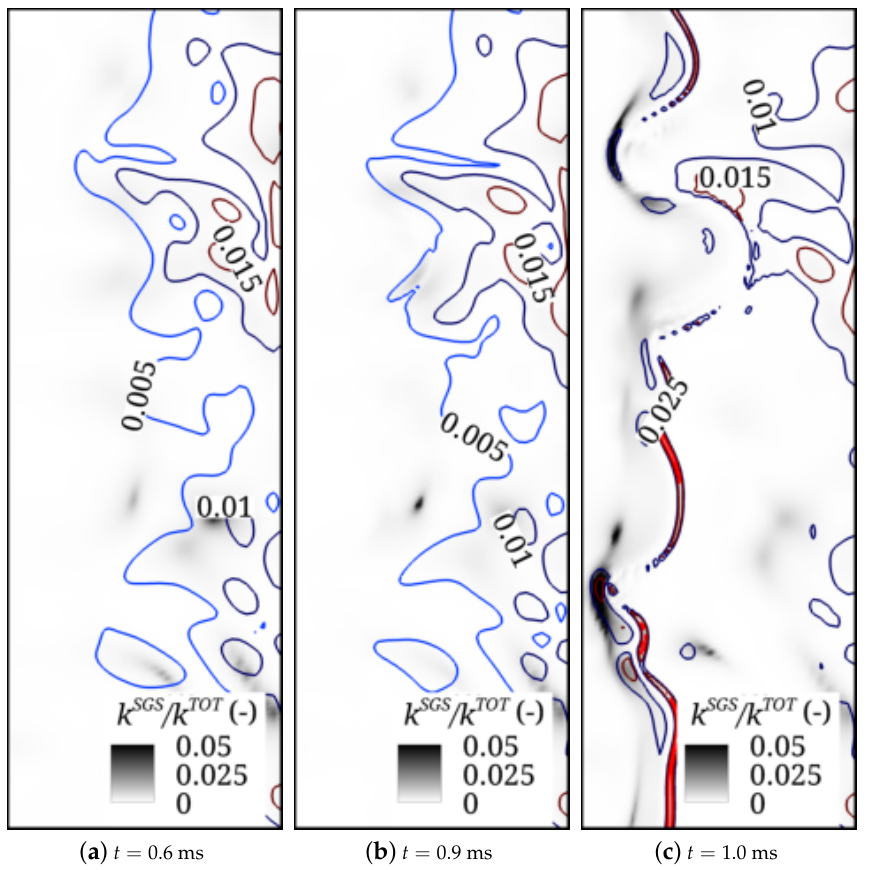
Figure 4. Contours of k SGS / k TOT and the iso-lines of µ t / µ in the central ‘y–x’ cross-section plane. The results obtained for the case HAT-200 before ( a , b ) and during the ignition phase ( c